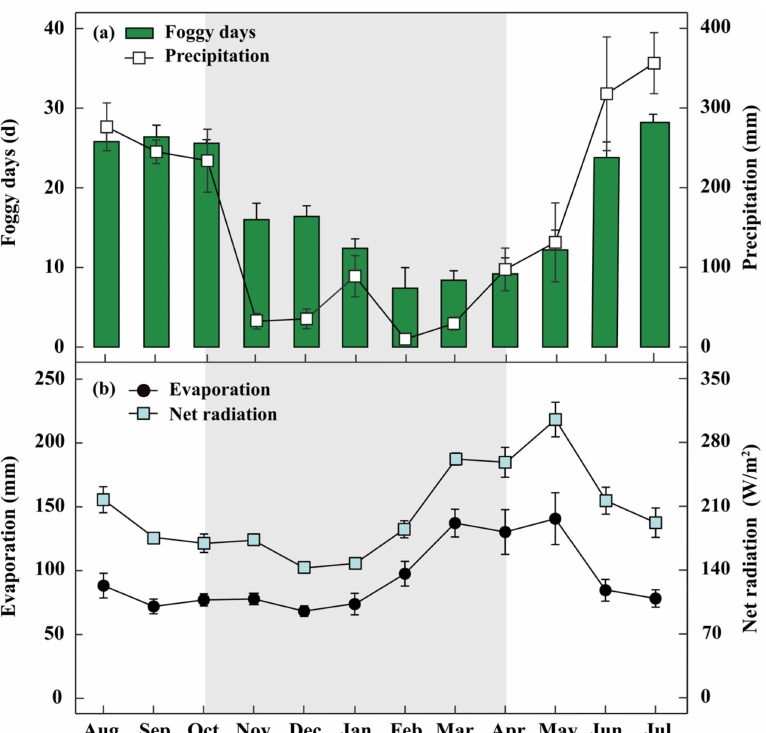
Figure 1. Meteorological conditions of the study site. Average monthly foggy days and precipitation (during 2015–2019; ( a )), as well as average monthly number of evaporation and net radiation ( b ) at the study site. The dry seasons from November to April are remarked by grey bars. Each vertical bar represents an average ( ± SE) for that